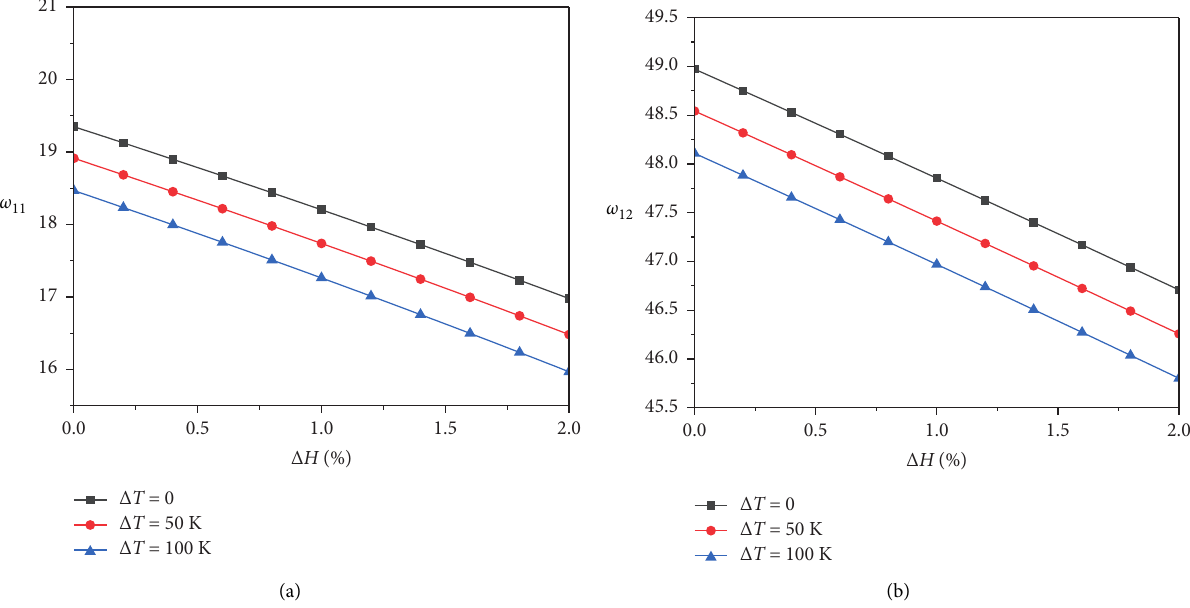
Figure 5: Variation of the vibration frequency with respect to moisture concentration under different temperature changing. (a) The first- order vibration frequency. (b) The second-order vibration